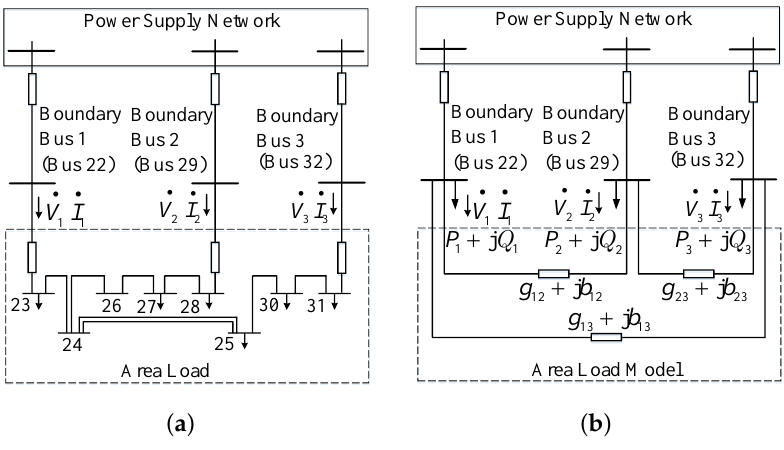
Figure 1. Area load modeling in the IEEE 57-bus power system. ( a ) The 57-bus power system with an area load; ( b ) the Ward equivalent model of the area